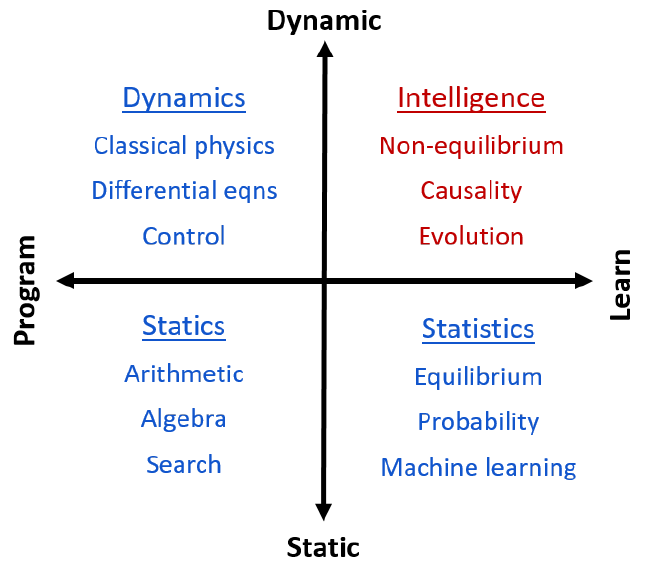
Figure 2. The conceptual landscape is divided into the same four domains described in Figure 1. The lower left domain of Statics is primarily concerned with quantification and counting. The upper left domain of Dynamics is primarily concerned with systems that change deterministically with time and are not too complex. The lower right domain of Statistics is primarily concerned with correlations in data sets collected from “noisy” environments which are not changing in time. The upper right domain of Intelligence is considerably less well developed and understood than the other domains.